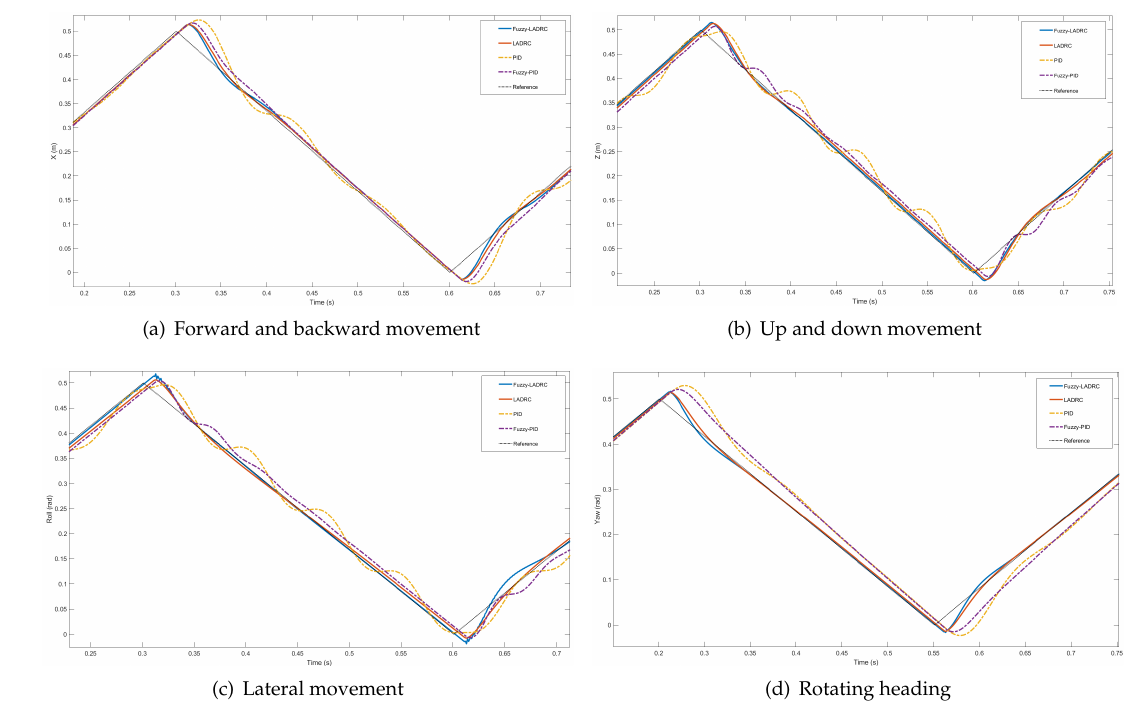
Figure 9. The results of tracking triangle wave signal.